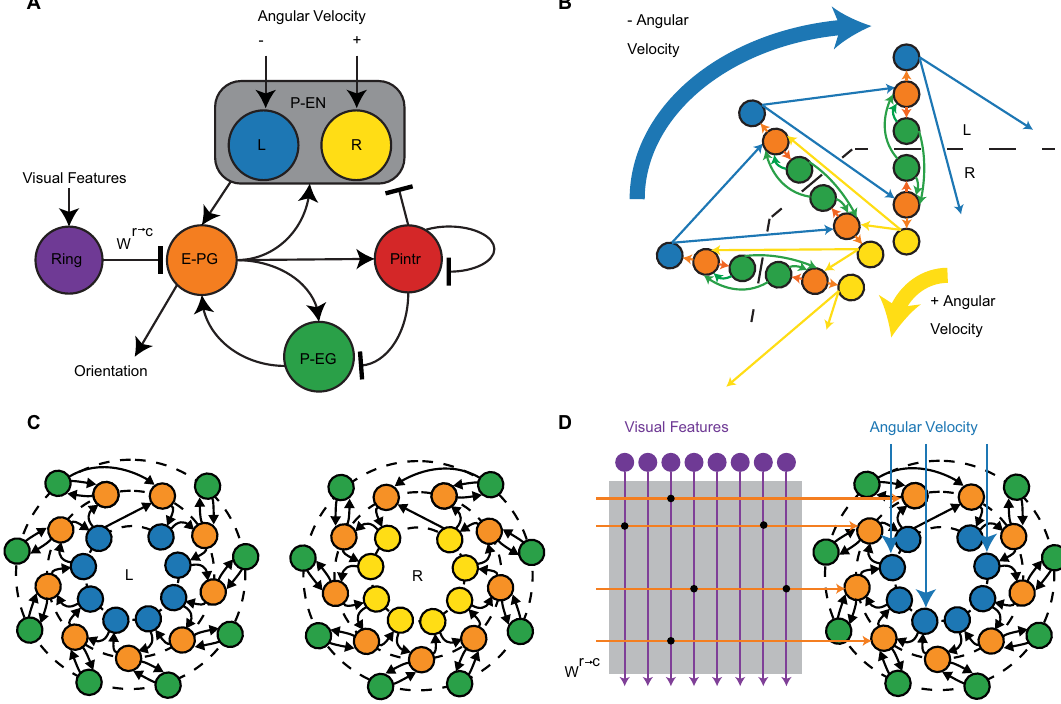
Figure 1. Drosophila CX ring attractor model for sensor fusion and environmental learning. ( A ) Five neuron types found in the Drosophila central complex (CX) included in the ring attractor model. Input is provided to the model as visual features to the ring neurons and angular velocity to the P-EN neurons. P-EN neurons are preferentially activated by positive and negative angular velocities according to if they are located in the left or right hemisphere of the PB. Orientation is encoded in E-PG compass neurons. All neuron types are excitatory except for Pintr and ring neurons which provide inhibition. ( B ) The primary repeated pattern in the connectivity constrained ring attractor network organized by E-PG neuron projecting to glomeruli in the left and right hemisphere of the PB. Local recurrent excitation enables the sustained activation of an activity bump, with positive or negative angular velocities shifting the center of the activity bump across the ring attractor network. ( C ) The connectivity pattern utilized for all excitatory modeled neurons separated by PB hemisphere. Note that there is one additional modeled E-PG neuron per hemisphere than other neuron types. ( D ) A weight r → c matrix, W , is learned, which specifies the strength of connections between ring neurons and compass